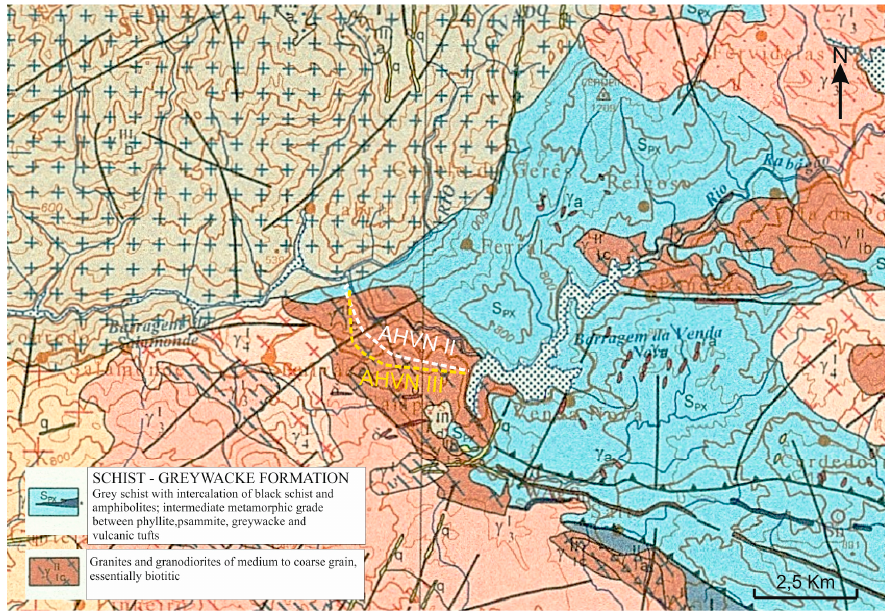
Figure 3. Infographics of geological settings at AHVNII and AHVNIII (adapted from [33]). As for previous hydraulic circuits, Picote II (AHP) is also built into granite. According to Pereira et al. [33], this was formed during the Variscan orogeny and is described as porphyritic, two-mica medium grain granite (Picote, Bemposta)—Figure 4.